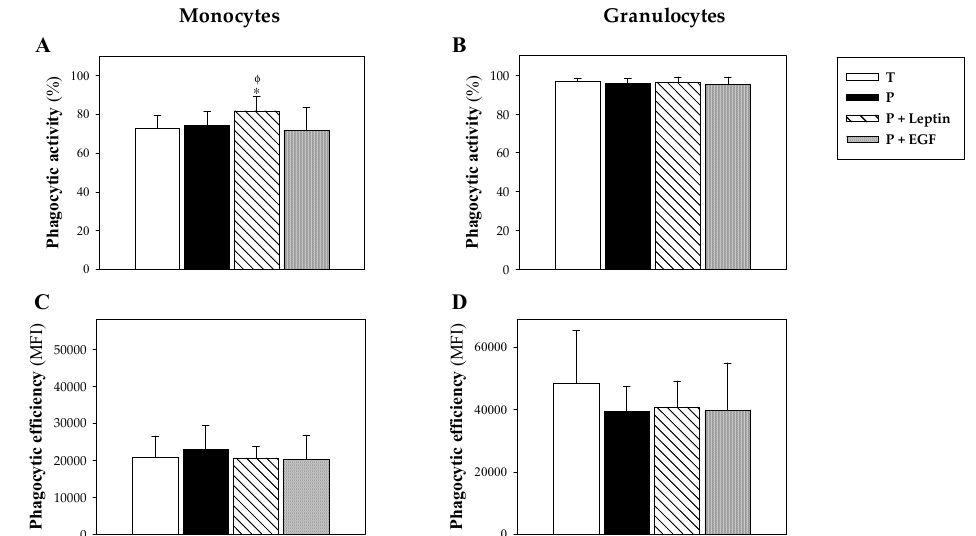
Figure 2. Phagocytic function of blood leukocytes from the four groups: Term (T), Preterm (P), P+Leptin, and P+epidermal growth factor (P+EGF). Phagocytic activity ( A , B ) and efficiency ( C , D ) at day 10 from monocytes and granulocytes, respectively. Results are expressed as mean ± SD ( n = 9 pups/group). Statistical differences: * p < 0.01 versus T group; φ p < 0.05 versus P group.